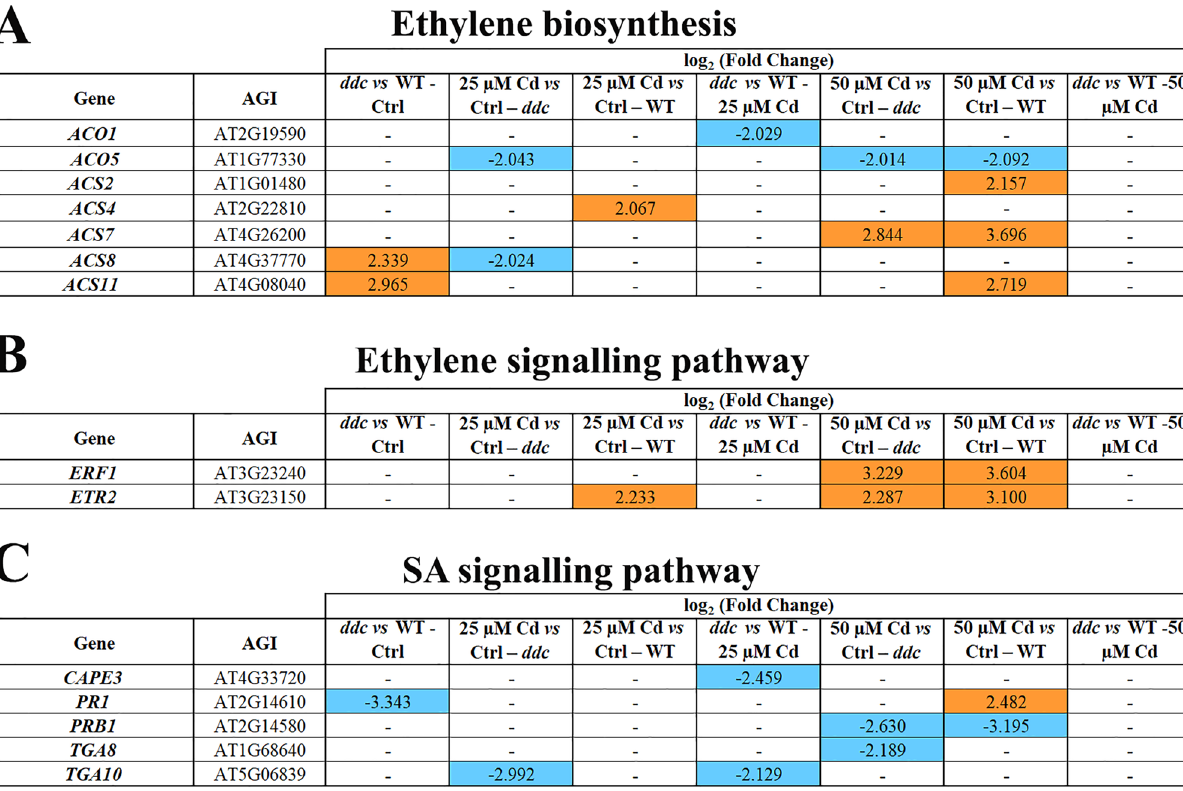
Figure 6. Genes differentially expressed (DEGs) along the pathway of ( A ) ethylene biosynthesis, ( B ) ethylene signalling and ( C ) SA signalling in ddc and WT plants identified through a transcriptomic approach. For each comparison, the log 2 (fold change) of the analysed DEGs was shown in orange and in blue for the upregulated and downregulated genes, respectively. Plants were grown for 21 DAG in long day condition: (i) on growth medium added with 25 or 50 µM Cd; (ii) on growth medium without Cd as control